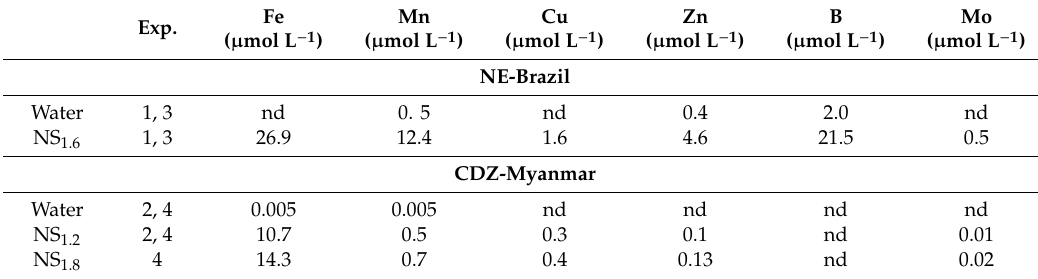
Table 2. Micronutrient concentrations in water and nutrient solutions (NS) adopted in the experiments in NE-Brazil and in CDZ-Myanmar.